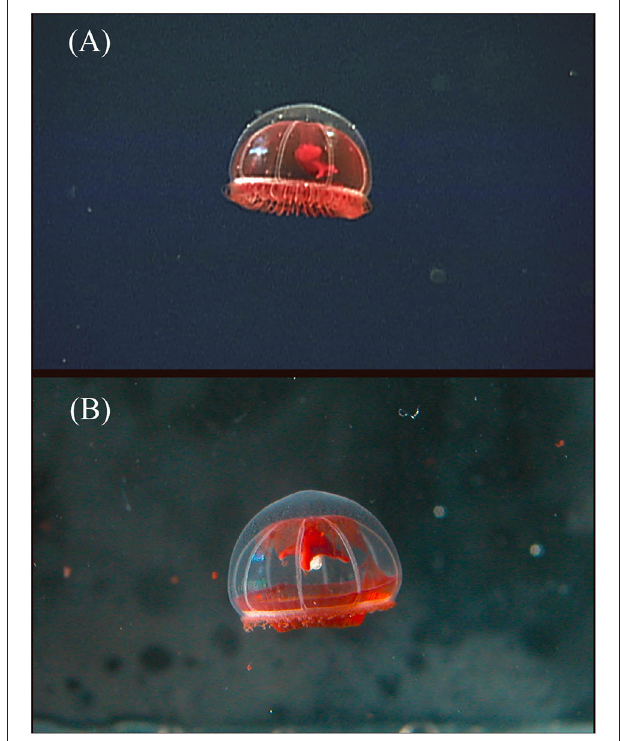
FIGURE 5 | Benthocodon pedunculatus collected on ROV Tiburon dive #836 at a depth of 3,419m in Monterey Bay, California in 2005. The two photos are of the same specimen, (A) is in situ and (B) is in the laboratory taken just after return to the surface. The red subumbrella had completely disappeared by the time the animal was preserved. This animal survived collection but has autotomized its outer ring of tentacles. The normally long manubrium has also retracted by at least 50% in length between the top and bottom image and the peduncle is harder to observe as